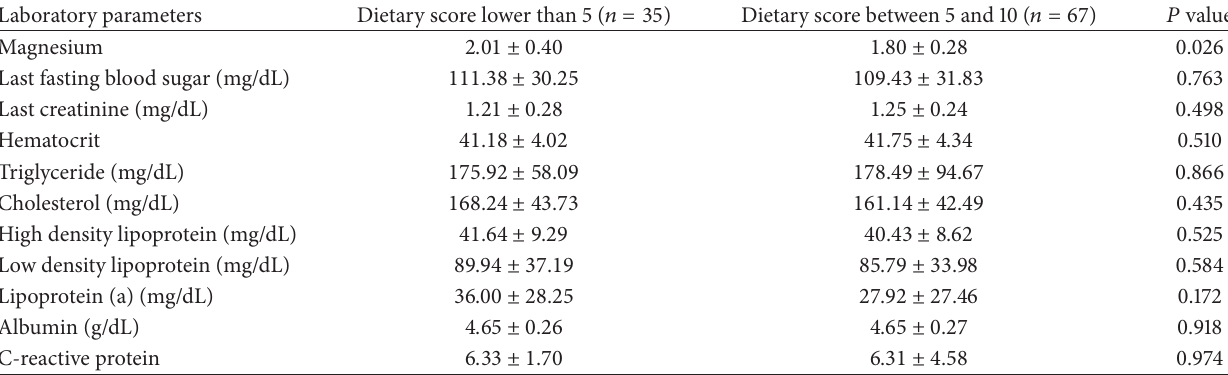
Table 3: Laboratory parameters in the groups with the dietary score lower than 5 and group with higher dietary score.